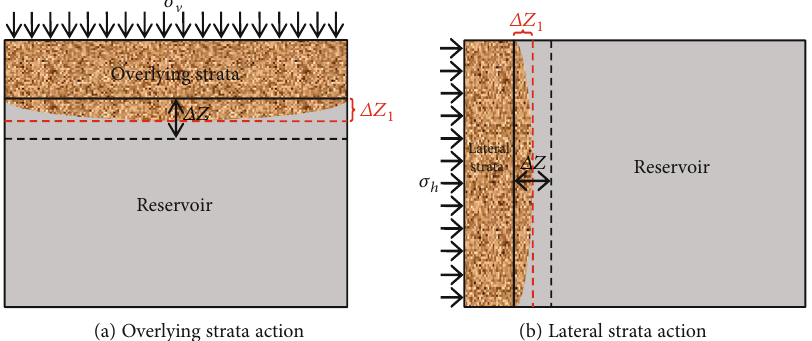
Figure 1: Stress-arching e ff ect on the reservoir boundary displacement.